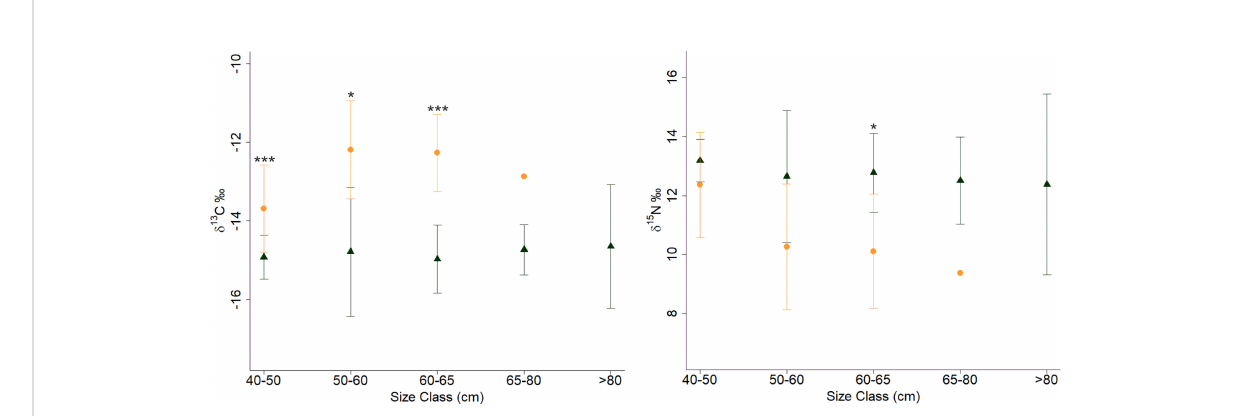
FIGURE 4 Carbon and nitrogen isotopic signatures (mean ± standard deviation) of green turtles from Unhocomo and Unhocomozinho foraging areas by curved carapace length (CCL, cm) size class. Color represents habitat of capture – black: rocky-bottom; orange: sandy-bottom. Statistically signi fi cance differences are represented as: * P < 0.05; *** P <